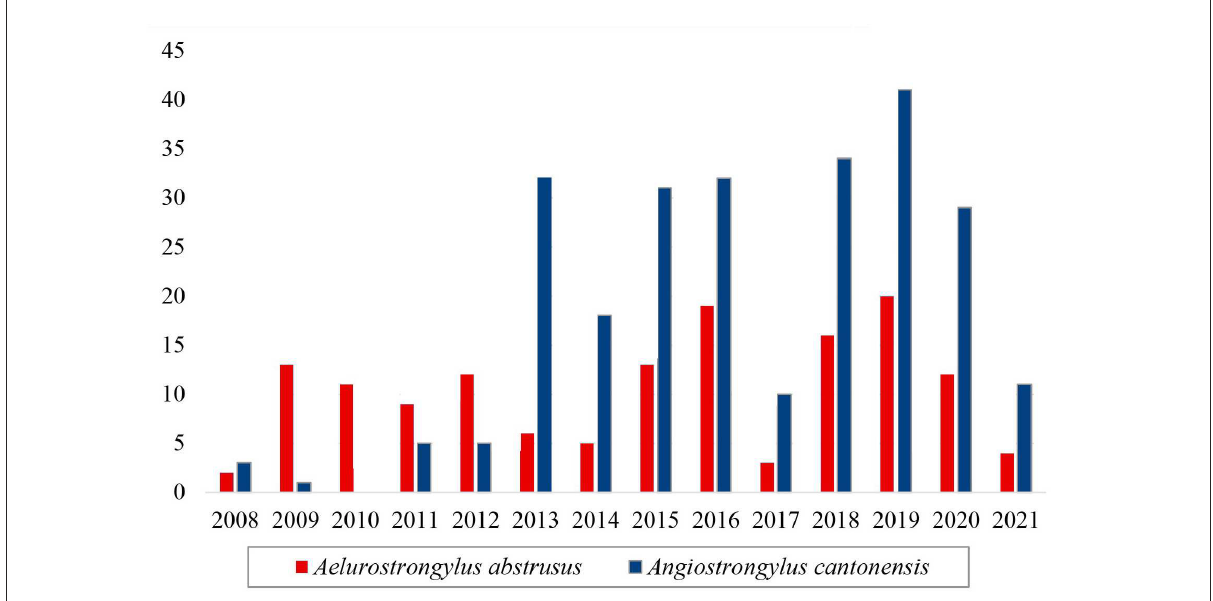
FIGURE5 Samples of the family Angiostrongylidae (Metastrongyloidea) identified as Aelurostrongylus abstrusus (red) and Angiostrongylus cantonensis (blue) in the LRNEM between 2008 and